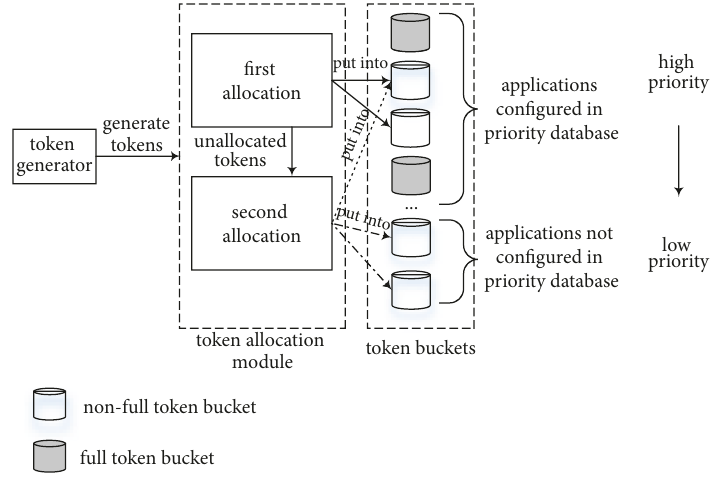
Figure 2: Flowchart of bandwidth dynamic scheduling method.